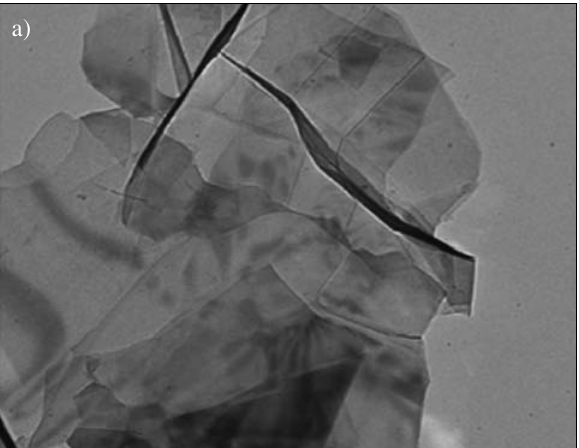
O (d) NiFe O 2 4 2 4